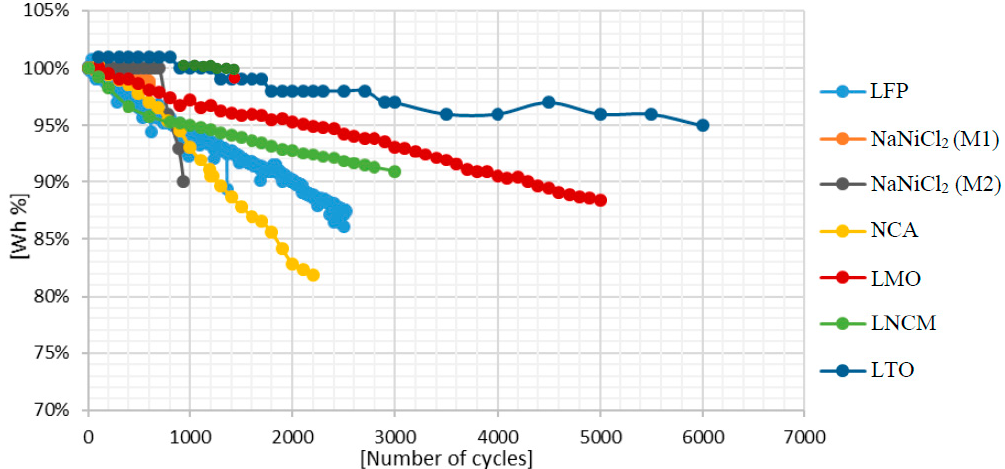
Figure 14. Comparative curves of ageing for different technologies based on the standard cycle.